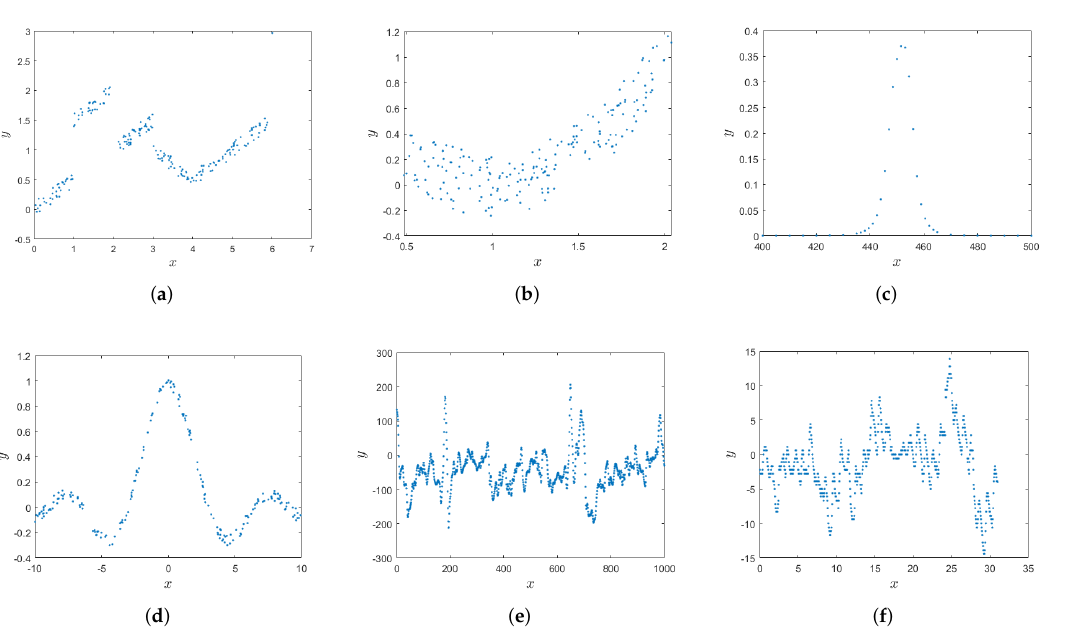
Figure 1. Graphical illustration of the three synthetic and three real-world data sets used in the numerical experiments: ( a ) Dataset 1; ( b ) Dataset 2; ( c ) Dataset 3; ( d ) Dataset 4; ( e ) Dataset 5; ( f ) Dataset